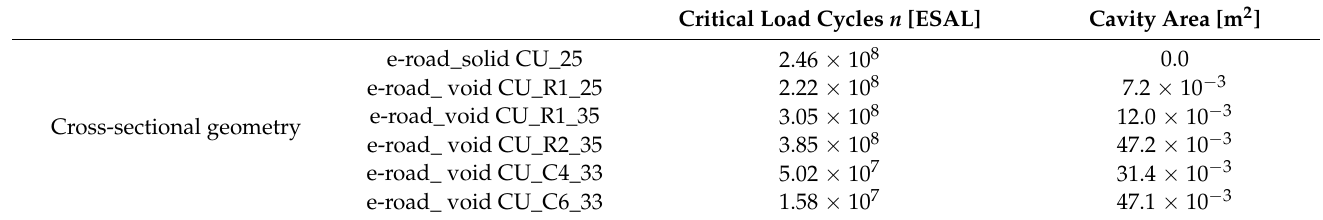
Table 7. Critical numbers of traffic repetition, according to different e-road cross-sectional geometries.